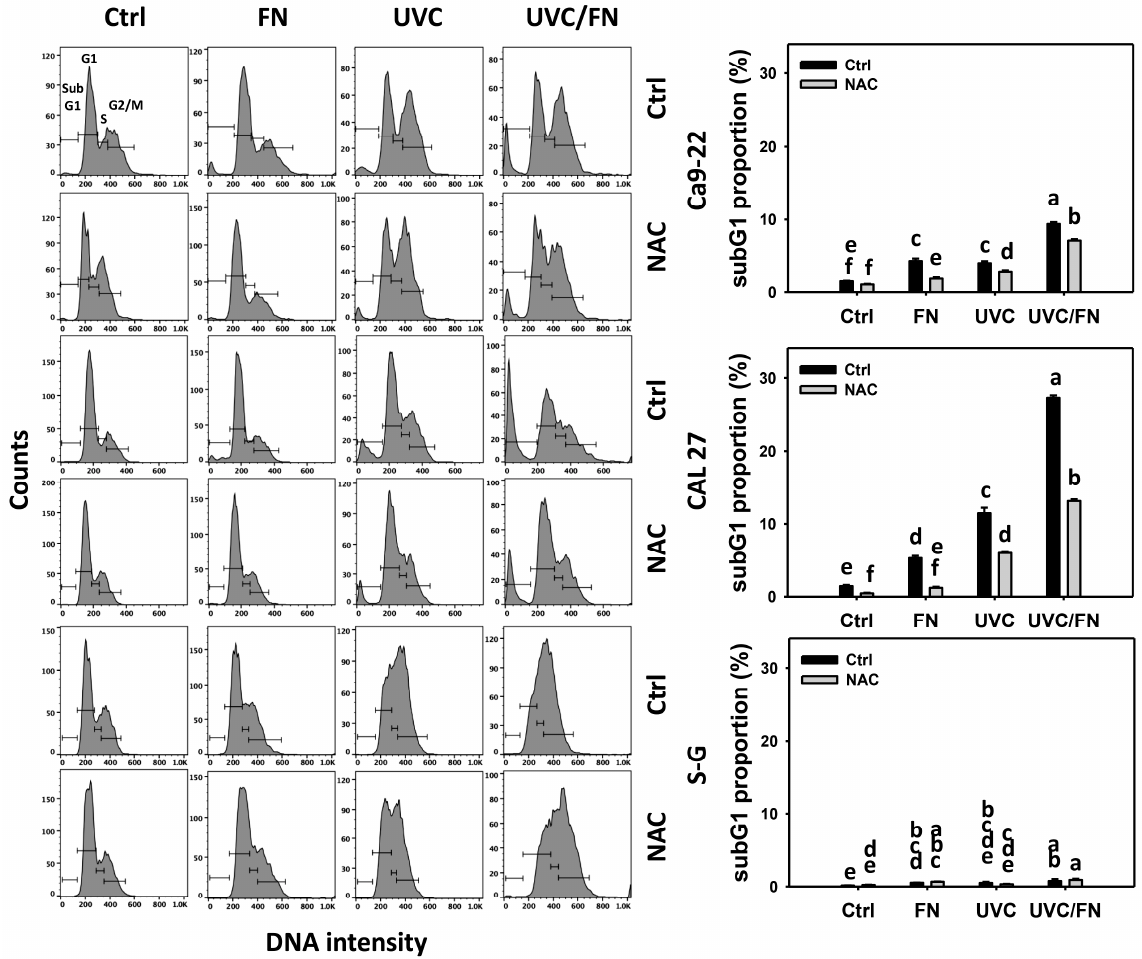
Figure 2. Cell cycle determination. There are four kinds of treatments for oral cancer (Ca9-22 and CAL 27) and non-malignant oral (S–G) cells: control, FN (300 µ g/mL), UVC (10 J/m 2 for Ca9-22; 15 J/m 2 for CAL 27 and S–G), and UVC/FN (10 J/m 2 /300 µ g/mL for Ca9-22; 15 J/m 2 /300 µ g/mL for CAL 27 and S–G). NAC indicates that cells were pretreated with 10 mM NAC. Their cell cycle changes were evaluated by flow cytometry after a 24 h treatment. Data are indicated as means ± SD ( n = 3). The low-case letters were assigned by JMP software to determine their significance. It significantly differs when the low-case letters are not overlapping ( p < 0.05).